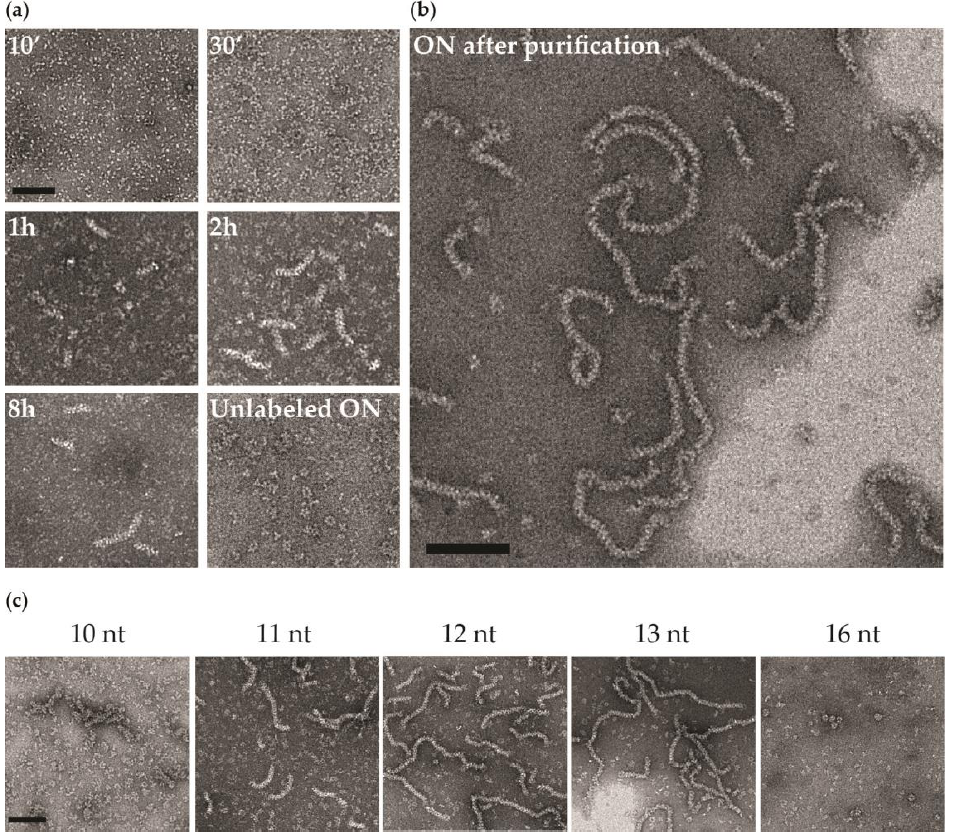
Figure 5. Ribonucleoprotein (RNP)-like species of influenza A virus nucleoprotein. Negative stain electron micrographs of A/NP with 5′ phosphate-(UC) 6 -FAM 3′ . Complexes (ratio 1:1) were incubated at room temperature in 20 mM Tris-HCl pH 7.5, 150 mM NaCl, and 5 mM β-ME. Samples were negatively stained with sodium silicotungstate. ( a ) Kinetics of RNP-like formation with a 12-nucleotide RNA. Electron micrographs were taken at different times after incubation with several RNAs at room temperature. With an unlabelled RNA, no worm-like structure is observed, even overnight; ( b ) Worm-like structures after purification by centrifugation (10 min, 11,000 × g , room temperature). The length of these species is random and they appear flexible. Similar to RNPs, these entities seem to be helical; ( c ) RNP-like species obtained with different RNA 5 (cid:48) phosphate-polyUC-FAM 3 (cid:48) lengths. With a 10-nt RNA, only a few short worm-like structures are observed. With 11 nt the worm-like structures are longer. With 12- and 13-nt RNAs, the worms are very similar with fewer trimers/tetramers in the background. The scale bars correspond to 100 nm. ON: